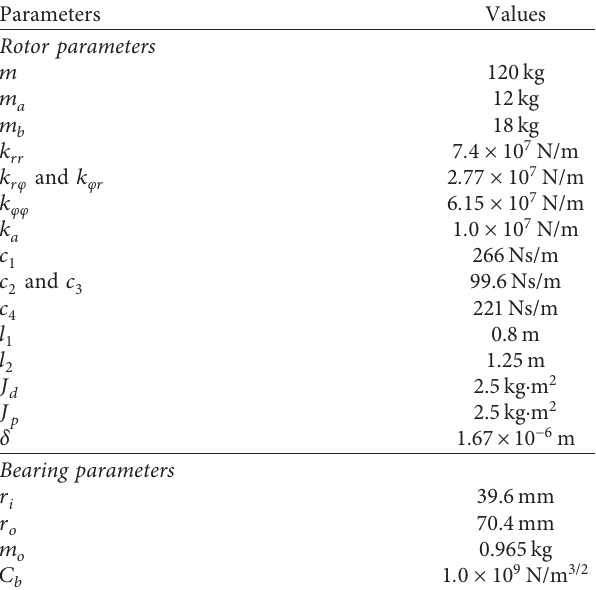
Table 1: The values of the parameters. Parameters